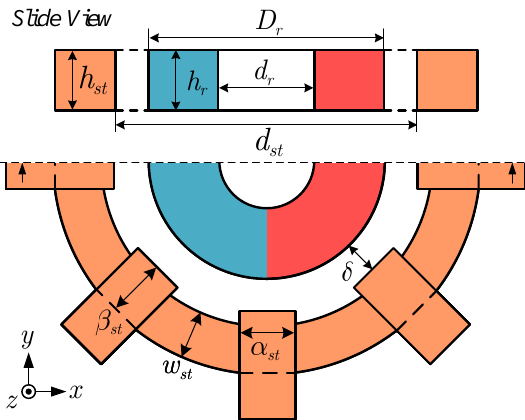
Figure 7. Parameterization of BPMSM geometry.